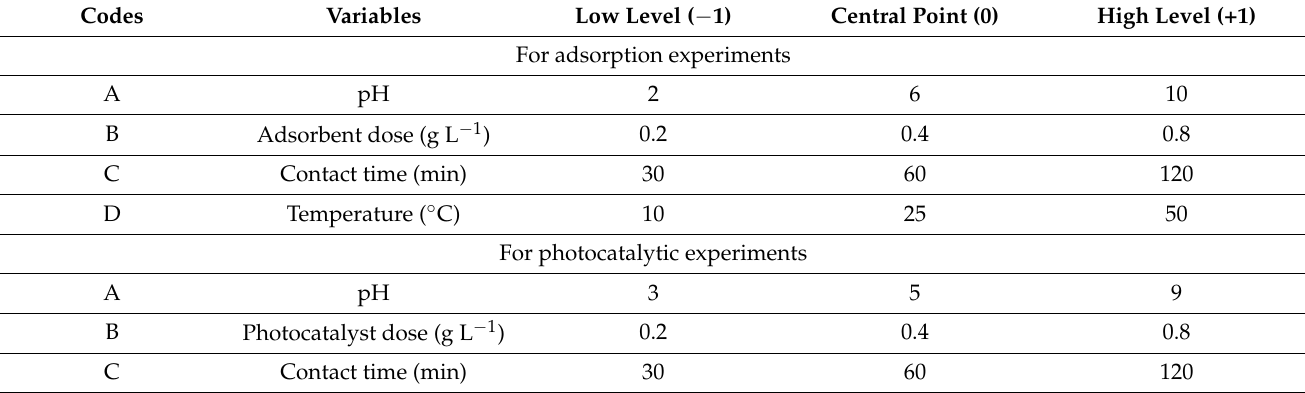
Table 8. Experimental levels of independent factors and their codes in a Box–Behnken